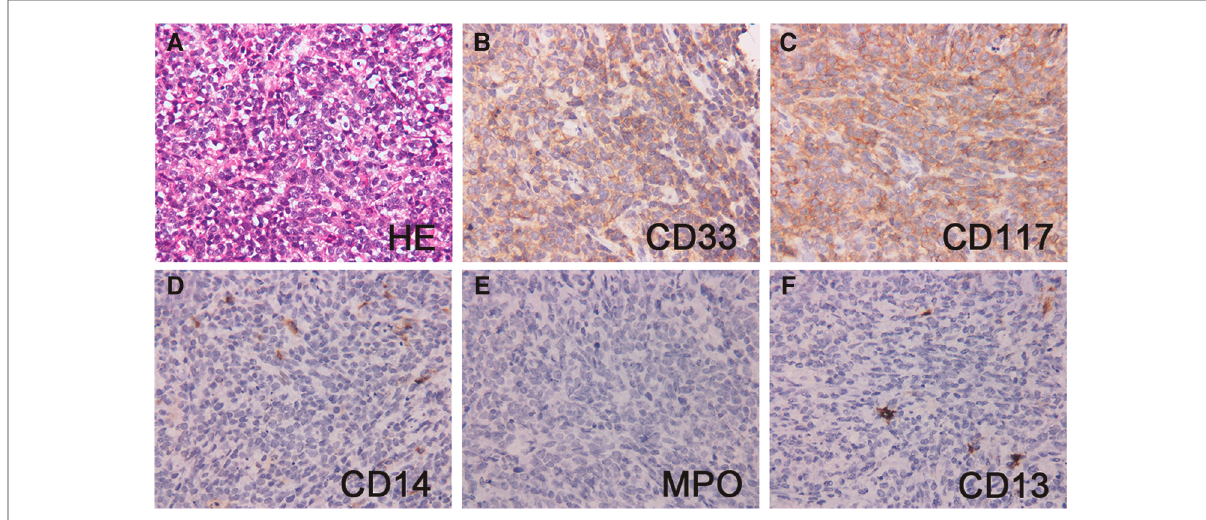
FIGURE 3 Pathological and immunohistochemical fi ndings of patient 11. H&E stain of a testis mass ( A ) showed mainly small round cells with abundant cytoplasm, large, irregular nuclei, and easily visible nuclear schizophrenic phase. The neoplastic cells strongly expressed CD33 ( B ) and CD117 ( C ), and the blasts were largely negative for CD14 ( D ), MPO ( E ) and CD13 ( F ). Original magni fi cation: